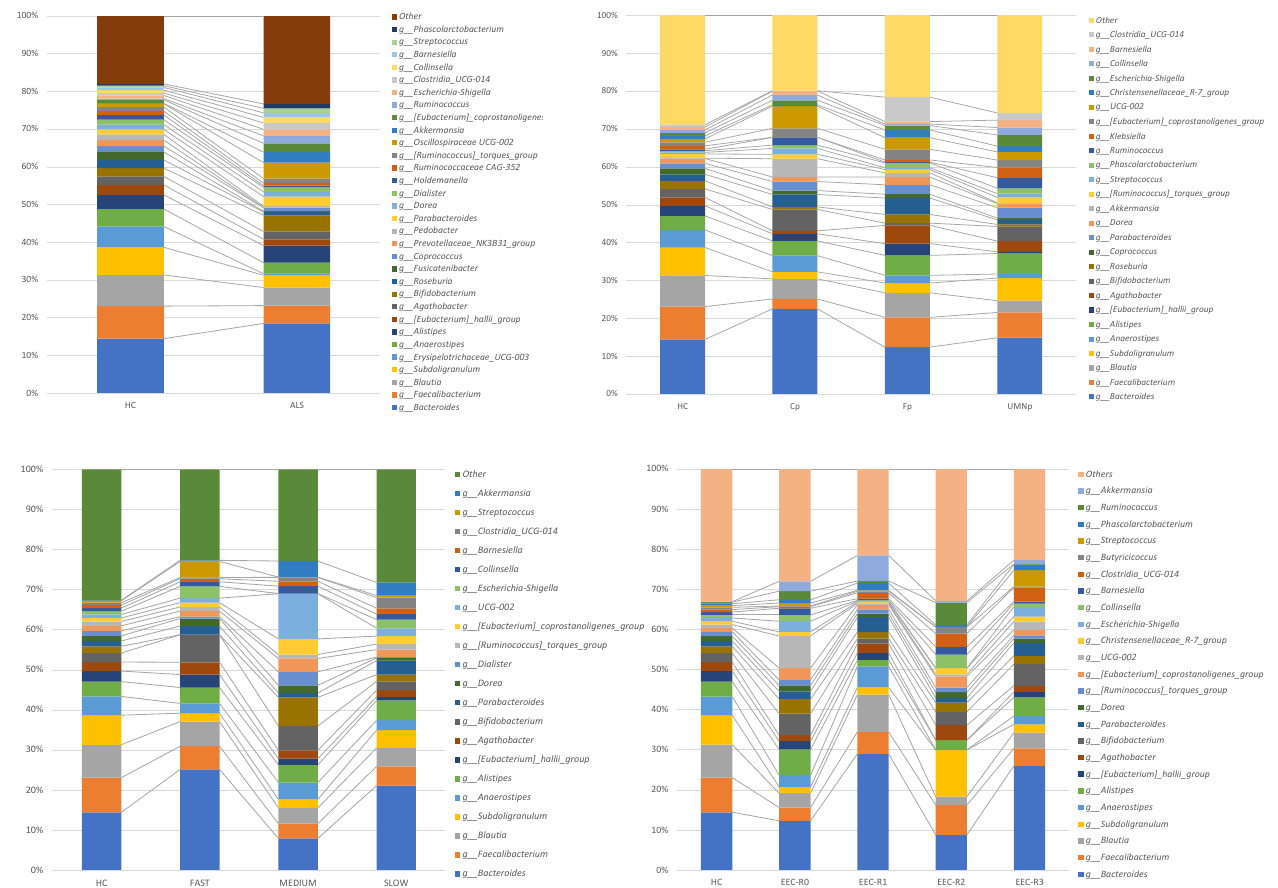
Figure 4. Stacked bar plots displaying the average relative abundance of bacterial amplicon sequence variants (ASVs) identified at the family taxonomic level in the gut microbiota of ALS patient subgroups and healthy controls. ALS = amy- otrophic lateral sclerosis. HC = healthy controls. EEC = EL Escorial Criteria; EEC-R0 = definite; EEC-R1 = clinically probable; EEC-R2 = probable-laboratory-supported; EEC-R3 = possible. Bp = Bulbar phenotype; Cp = Classic phenotype; Fp = Flail arm/leg phenotype; UMNp = Upper Motor Neuron predominant phenotypes.